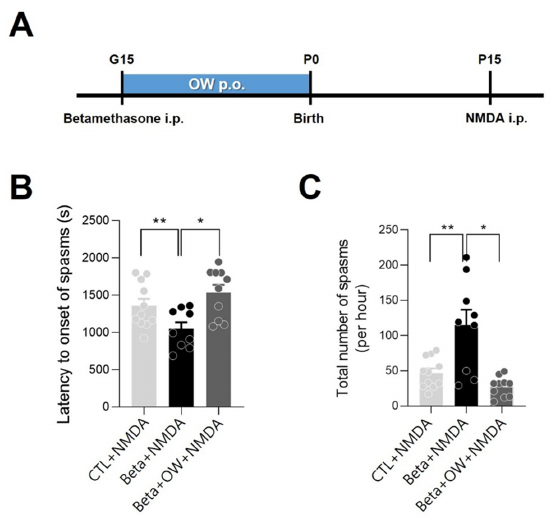
Figure 1. Effect of oxygenated water (OW) in offspring following prenatal exposure to betamethasone. ( A ) After intraperitoneal (i.p.) betamethasone injection, OW was administered orally (p.o.) to pregnant rats from gestational day (G)15 to birth. ( B ) The latency (seconds) and ( C ) frequency (per hour) to the onset of flexion spasms induced by intraperitoneal N-methyl-D-aspartate (NMDA) was measured in the control (CTL) and betamethasone (Beta)-treated postnatal day (P)15 rats. Compared with the control and prenatal betamethasone plus OW group, the betamethasone-treated group showed increased frequency and decreased latency to spasm onset. Error bars denote standard error of the mean (SEM). One-way analysis of variance (ANOVA), Newman–Keuls post hoc test: * p < 0.05, ** p < 0.005.